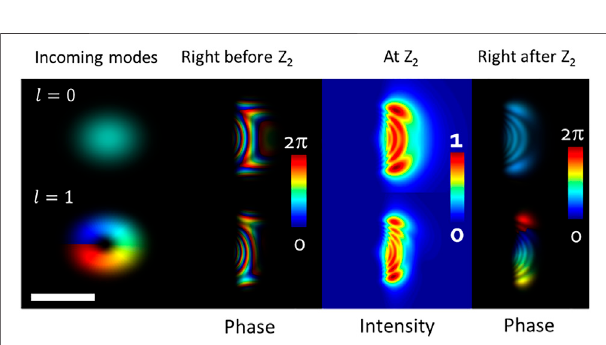
FIGURE 3 | Combined representations of the intensities and phases of modes l = 0, 1 are provided before and as after the elements, as brightness and colors refer, respectively, to intensity and phase of each beam. Scale bar, 50 μ m.